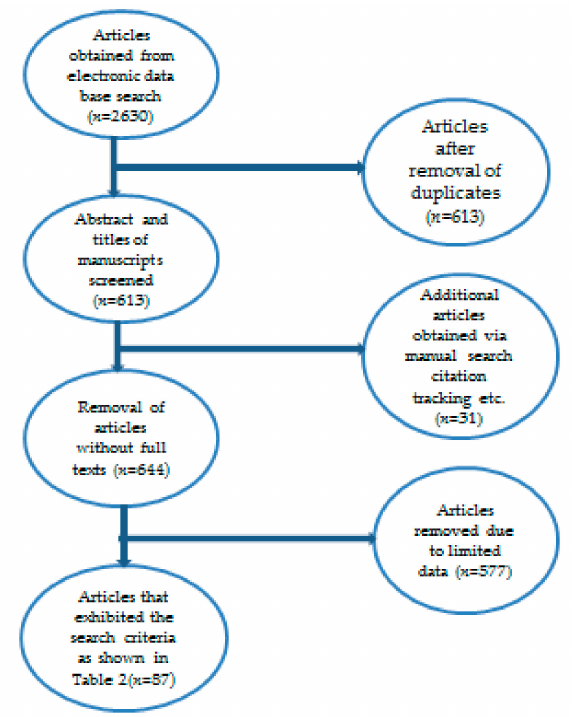
Figure 1. An overview of the procedure applied for the identification of 87 articles included in this